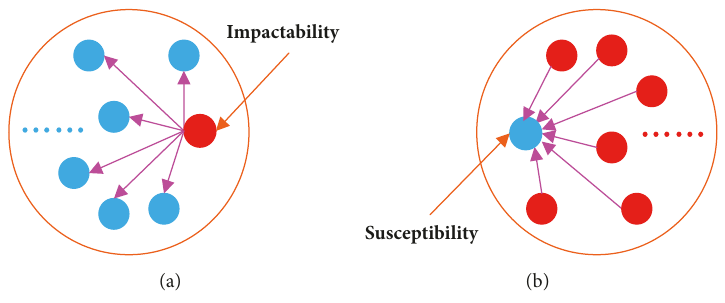
Figure 4: The diagram to explain impactability and